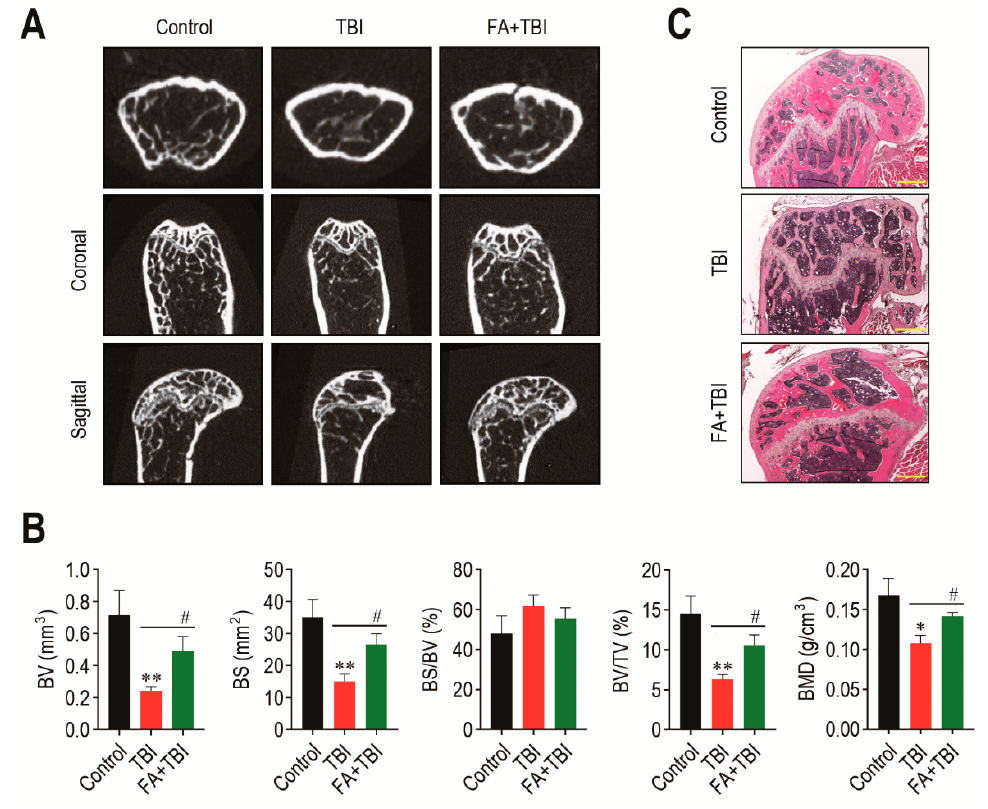
Figure 3. Administration of ferulic acid restores TBI-mediated impairments in BM microenvironment and bone mass accrual. ( A ) The 2D μ CT images show femoral bones of mice groups 60 days after TBI. ( B ) Values of bone parameters, including BV (mm 3 ), BS (mm 2 ), BS/BV (%), BV/TV (%), and BMD (g/cm 3 ), in the trabecular region of the femoral bones were measured 60 days after TBI ( n = 4). ( C ) Histological evaluation of bone mass accrual at the trabecular bones of mice groups was performed by H&E staining at 60 days post-TBI. A representative result from four different samples is shown. Scale bar = 500 µ m. All data are presented as the mean ± SD. * p < 0.05 and ** p < 0.01 compared with control group; # p < 0.05 compared with TBI group.